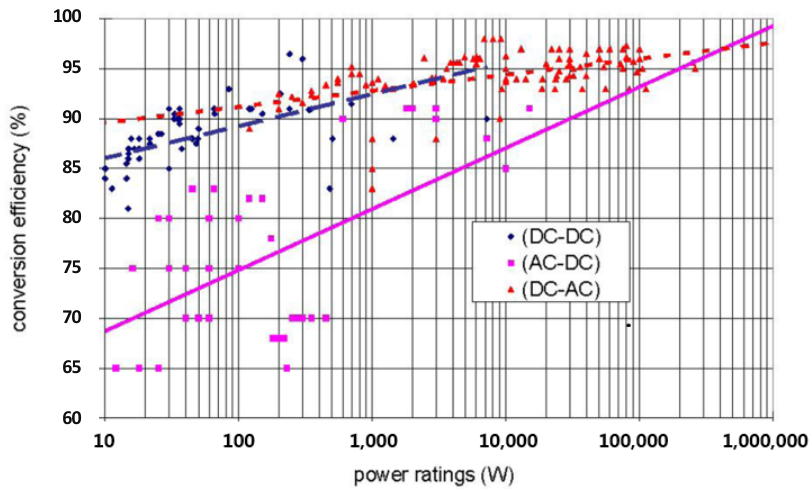
Figure 3. Converter efficiency for each converter type.